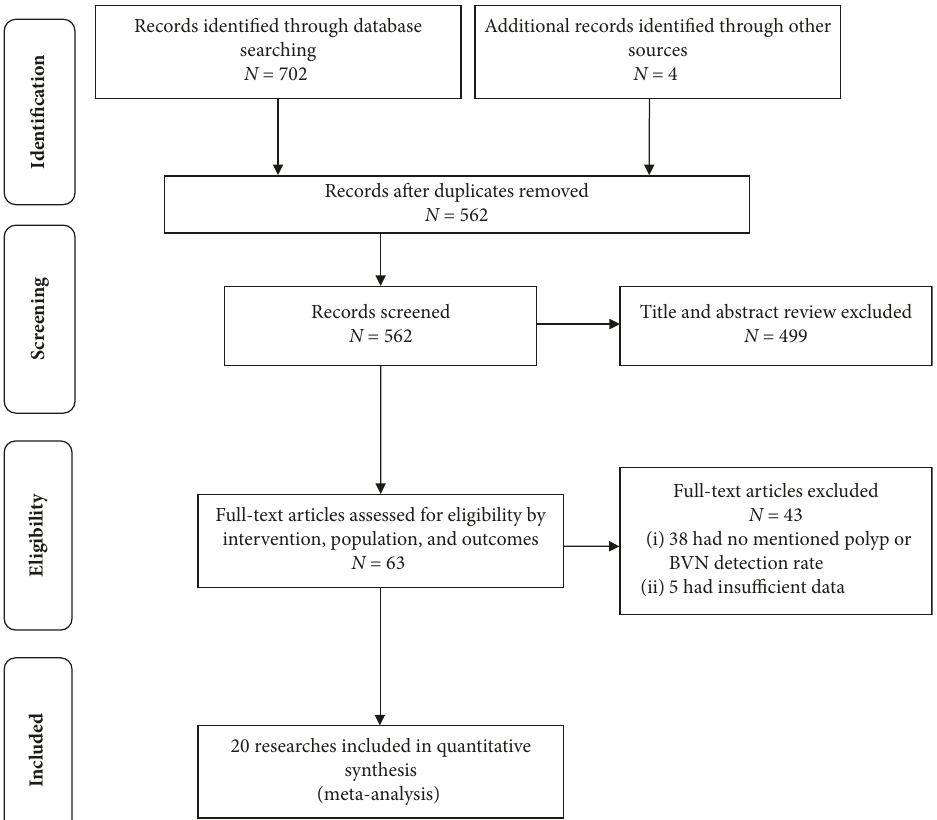
Figure 1: Flowchart of study selection. BVN indicates the branching vascular